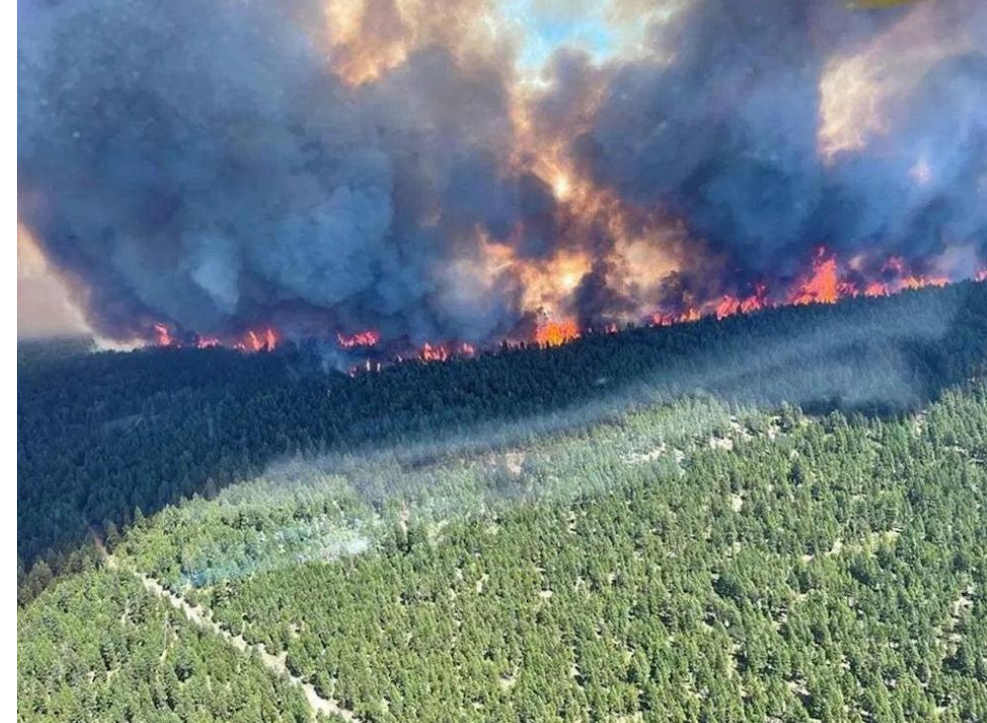
Figure 1. Wildfire in British Columbia, end of June 2021. See Figure 4 for location map of maximum temperatures near Lytton, BC. Source: BC Wildfire Service/AFC via Gett.